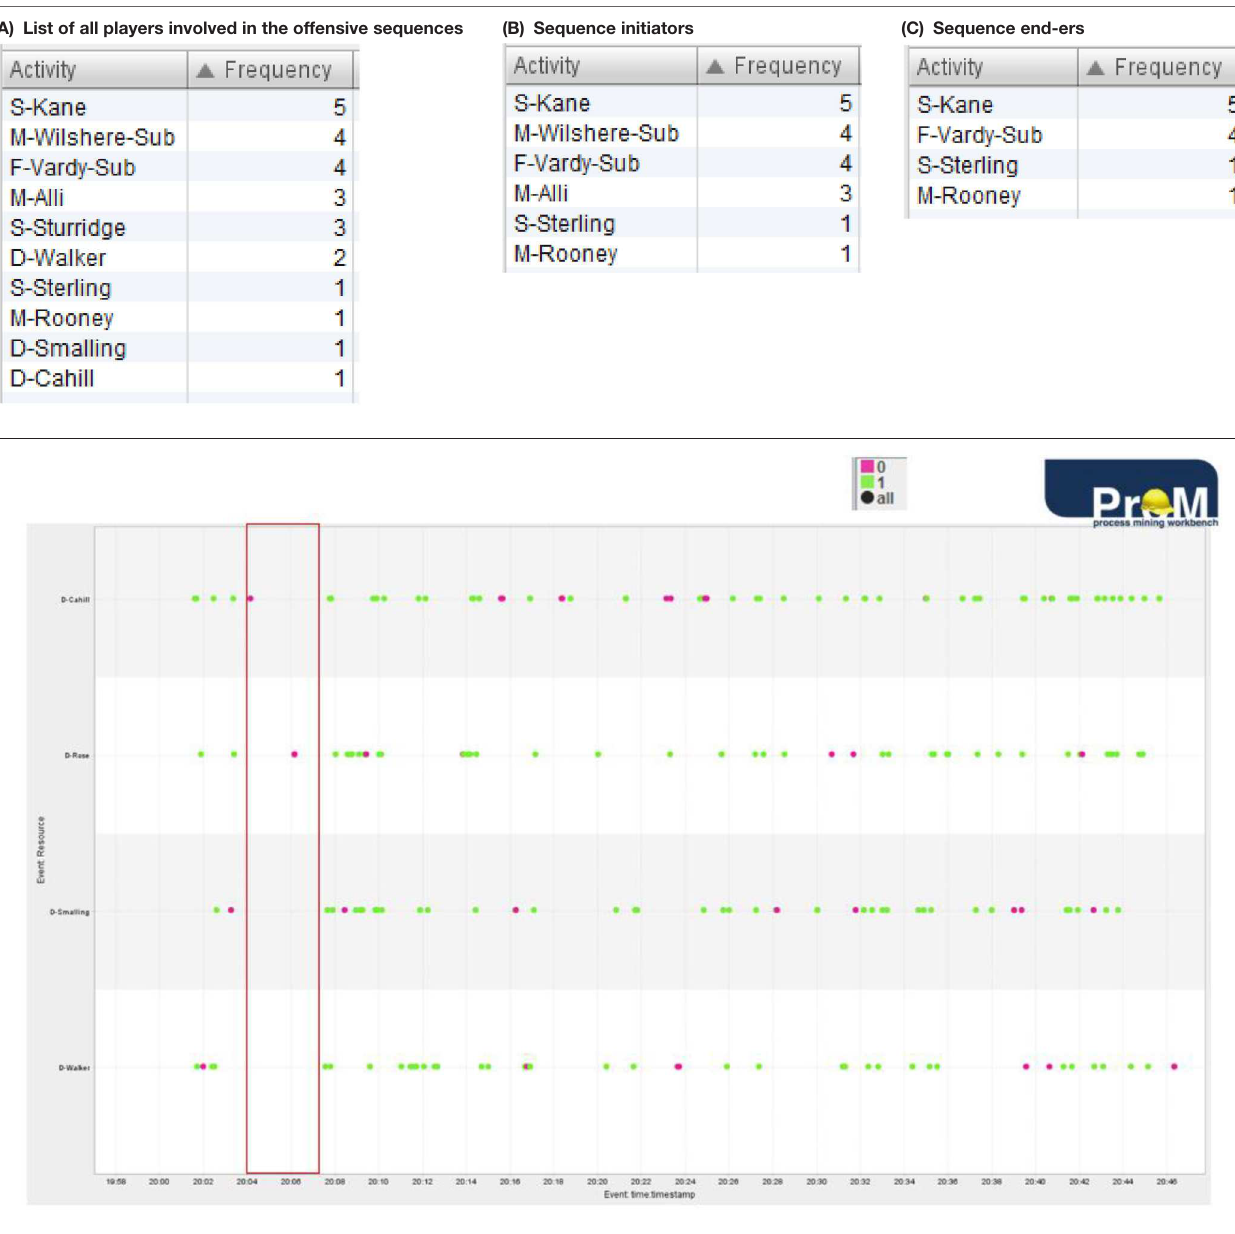
TABLE 3 | Overview of players involved in offensive sequences.